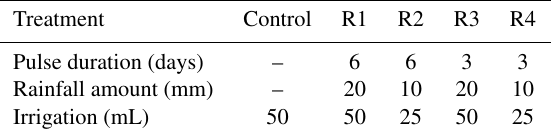
Table 1. Simulated rainfall (watering) treatments utilised in this study. Pulse durations and rainfall amounts were selected from in- terrogating long-term weather data accessed from the Newman Air- port weather station (CSIRO and Bureau of Meteorology, 2007). Simulated rainfall treatments (R1–R4) comprised repeat daily ap- plications of water for either 6 or 3 days and two different rainfall amounts (20 or 10mm). The total irrigation amount of 50 or 25mL matched the pot sizes used in this study and rainfall amount treat- ments required to simulate the desired simulated rain